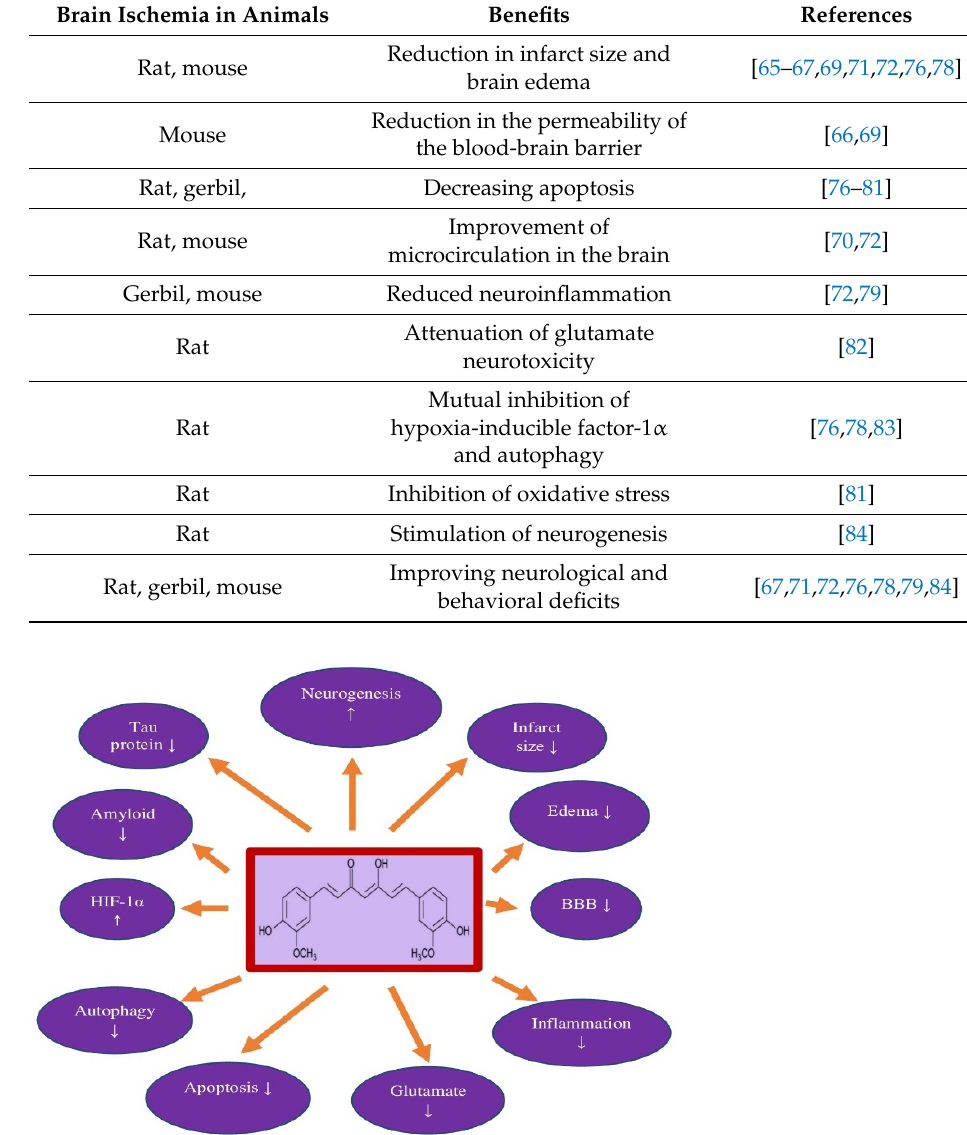
Table 1. Protective action of curcumin in post-ischemic neurodegeneration of the brain.